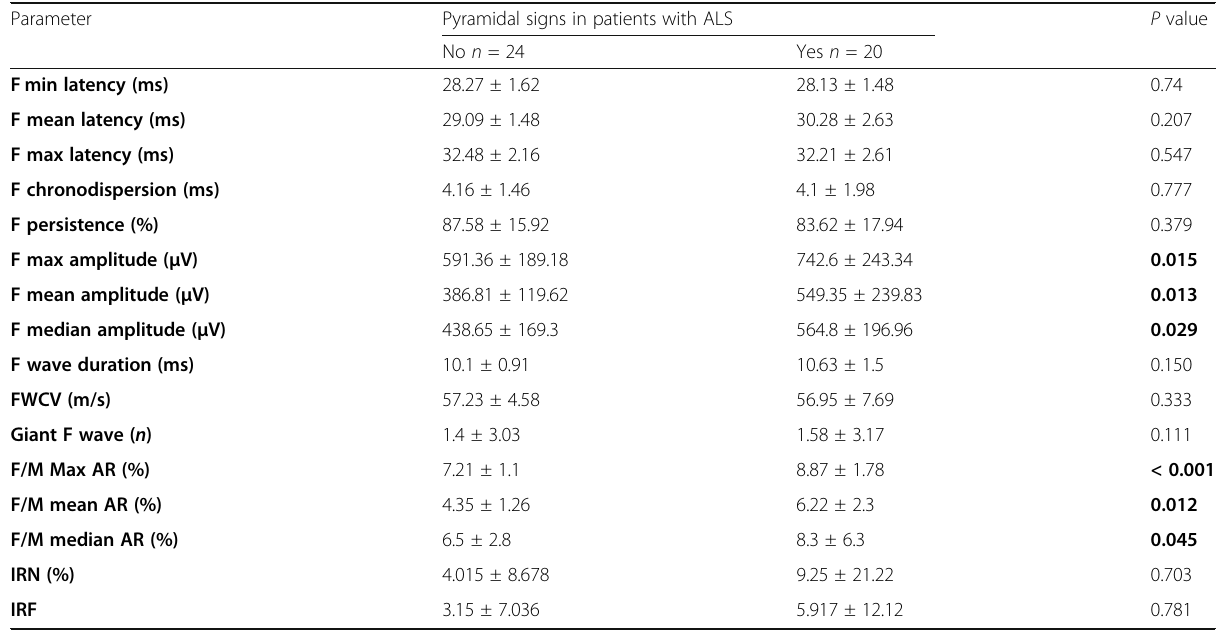
Table 3 F wave parameters recorded from ADM muscle in patients with ALS with and without pyramidal signs